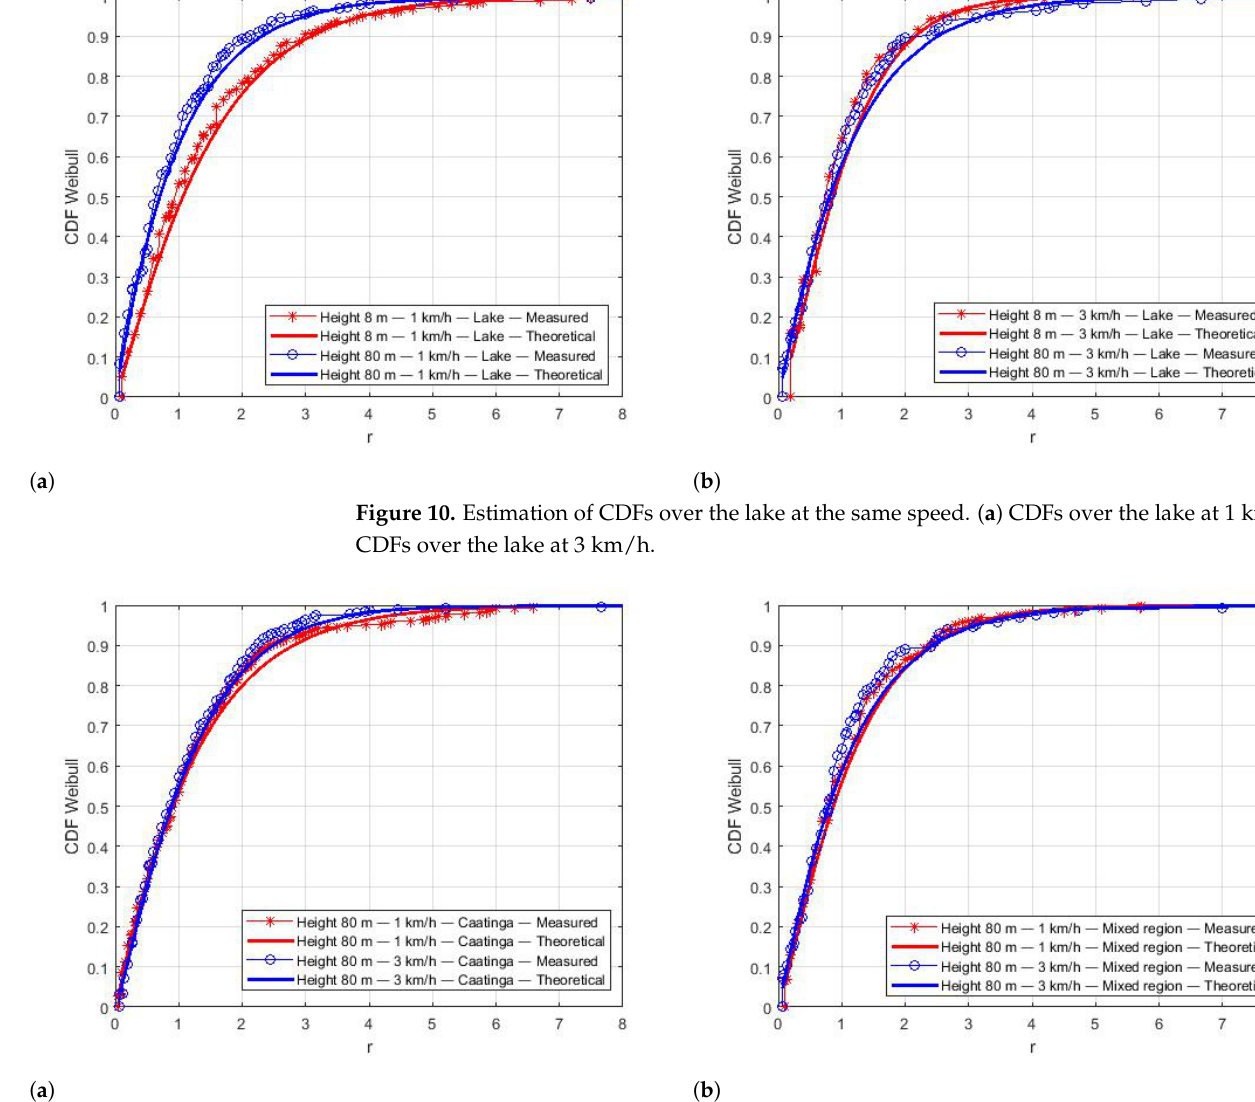
Figure 11. Estimation of CDFs for the Caatinga and Mixed environments. ( a ) CDFs for the Caatinga region. ( b ) CDFs for mixed